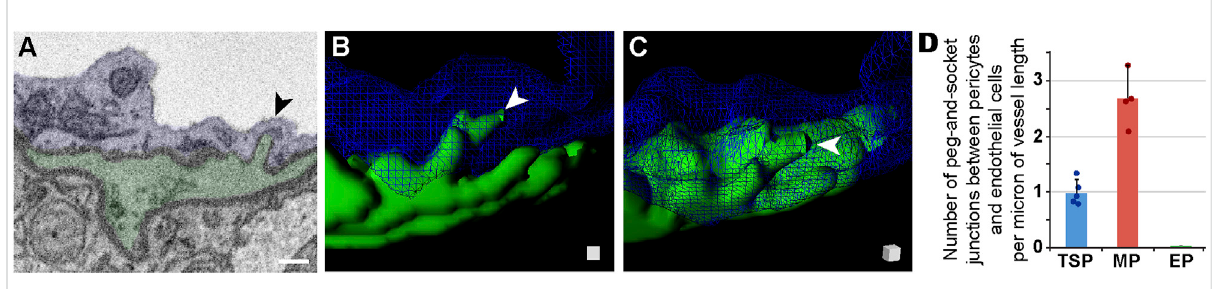
Peg-and-Socket SEM Images, 3D Rendering, and Quanti fi cation from Mouse Brain Microvessels. (A) Representative SEM image of a peg-and- socket structure formed by a microvessel EC (blue, pseudo-colored) and adjacent PC (green, pseudo-colored). Arrow denotes the peg-and-socket location. Scale bar, 500 nm. (B) 3D reconstruction of a vessel cross-section with the EC (blue, wire-frame rendering) and PC-derived “ peg ” (green), noted by a white arrowhead. See Supplementary Video S4. (C) 3D rendering of “ peg ” shown in (B) with a slight rotation in angle, which is represented by the surface-shaded cube in the lower right corner. “ Peg ” denoted by white arrowhead. (D) Bar graph displaying the number of peg- and-socketjunctionsbetweenPCsandECspermicronofvessellengthforeachPCsubtype.Atotalofn=12vesselswereanalyzedfromn=10mice. Error bars denote standard deviations.